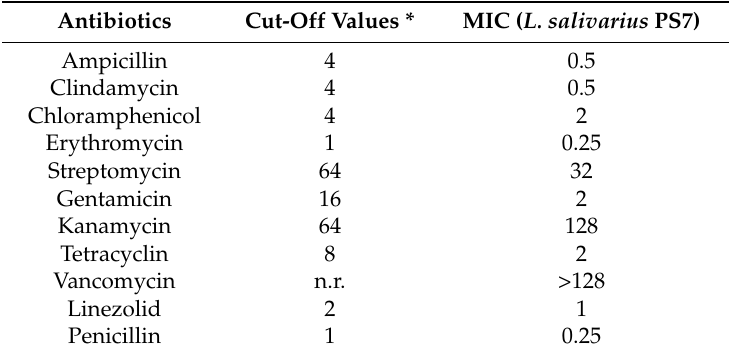
Table 3. Minimum inhibitory concentrations (MICs) and cut-off values ( µ g/mL) of a variety of antibiotics for L. salivarius